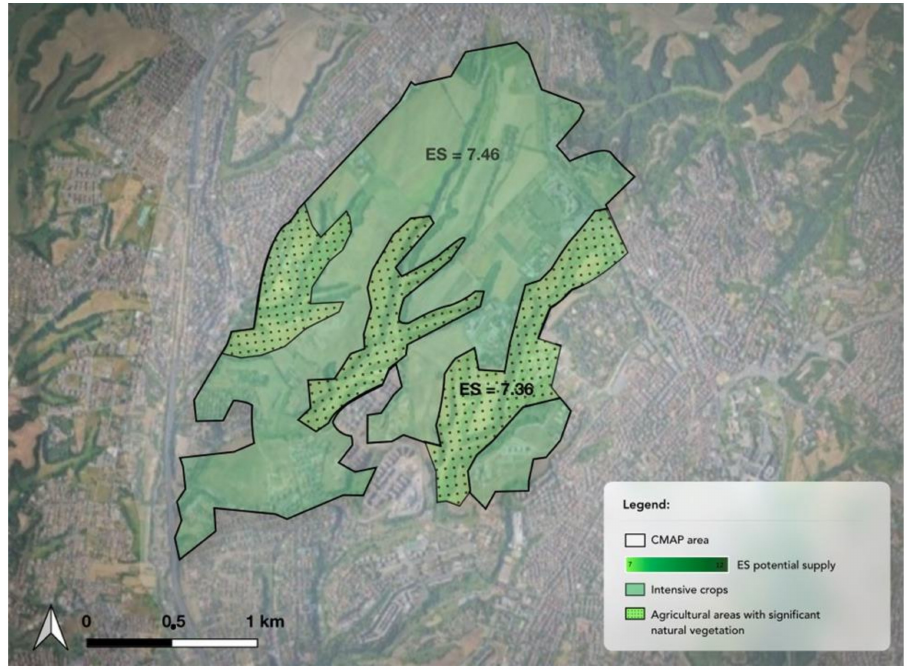
Figure 6. CMAP area: ES participatory mapping of the main ES.